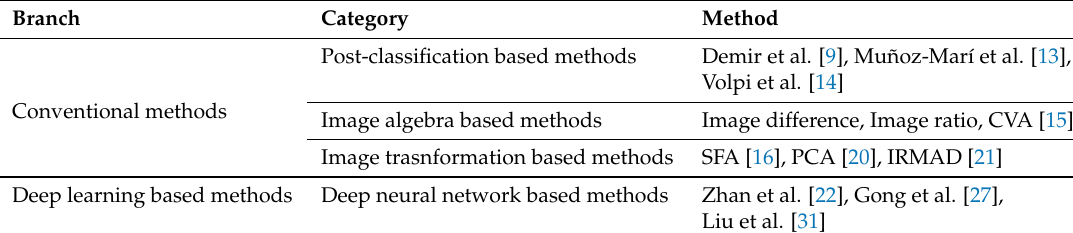
Table 1. The change detection